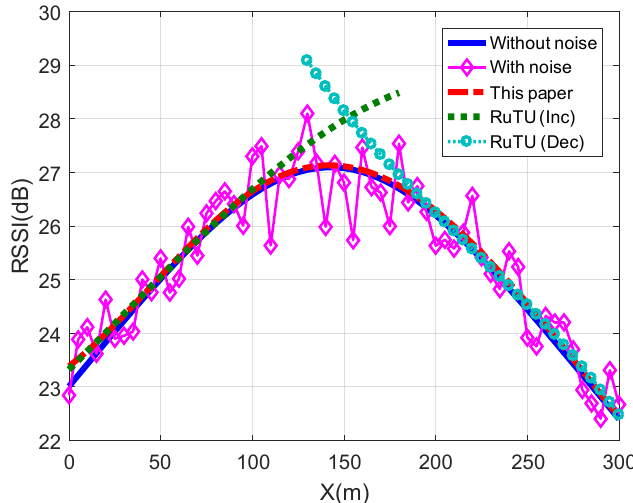
Figure 12. Determining the projection of one node on the trajectory by three schemes ( ∆ L = 10